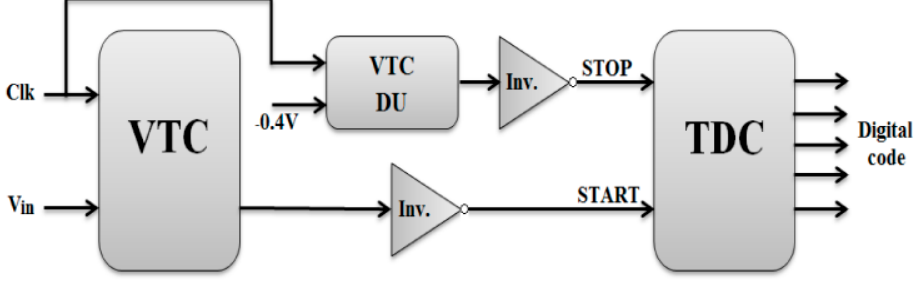
Figure 21. Interface circuit for the first proposed VTC.